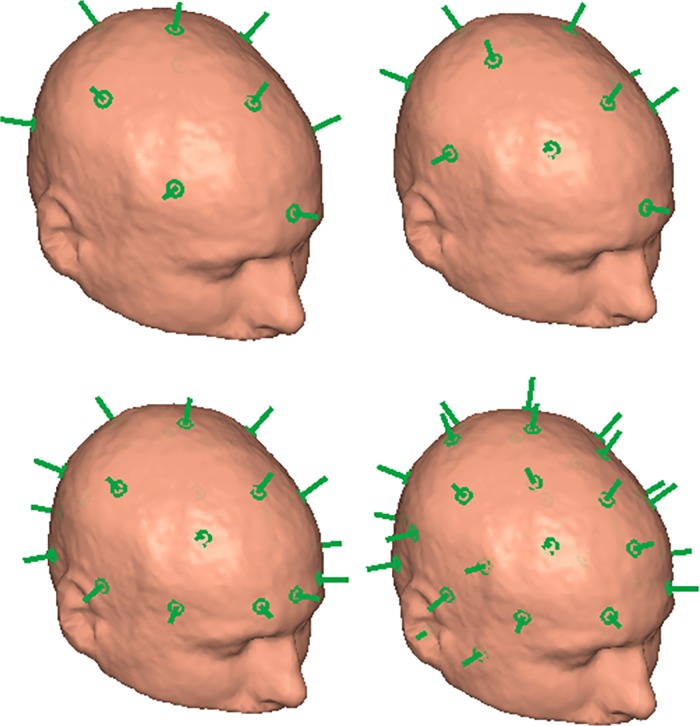
Full-head localization coil arrays.Localization coil placement in 10- (top-left), 12- (top-right), 21- (bottom-left) and 32- (bottom-right) coil full-head arrays.